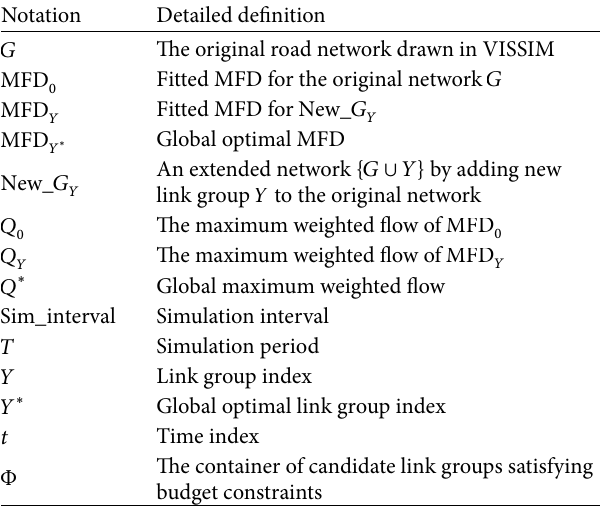
Table 2: Notations and definitions in the solution algorithm.